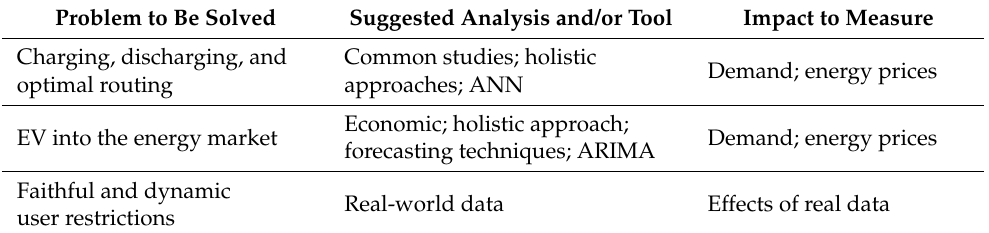
Table 6. Problems, suggestions, and impacts of EVs. Source: own study. Problem to Be Solved